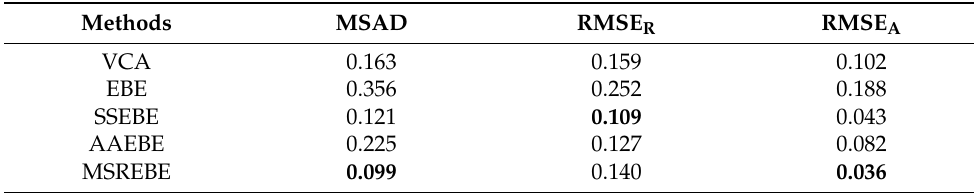
Figure 12. The endmember extraction results of Jasper Ridge dataset. Table 3. Experimental results of Jasper Ridge dataset. Methods